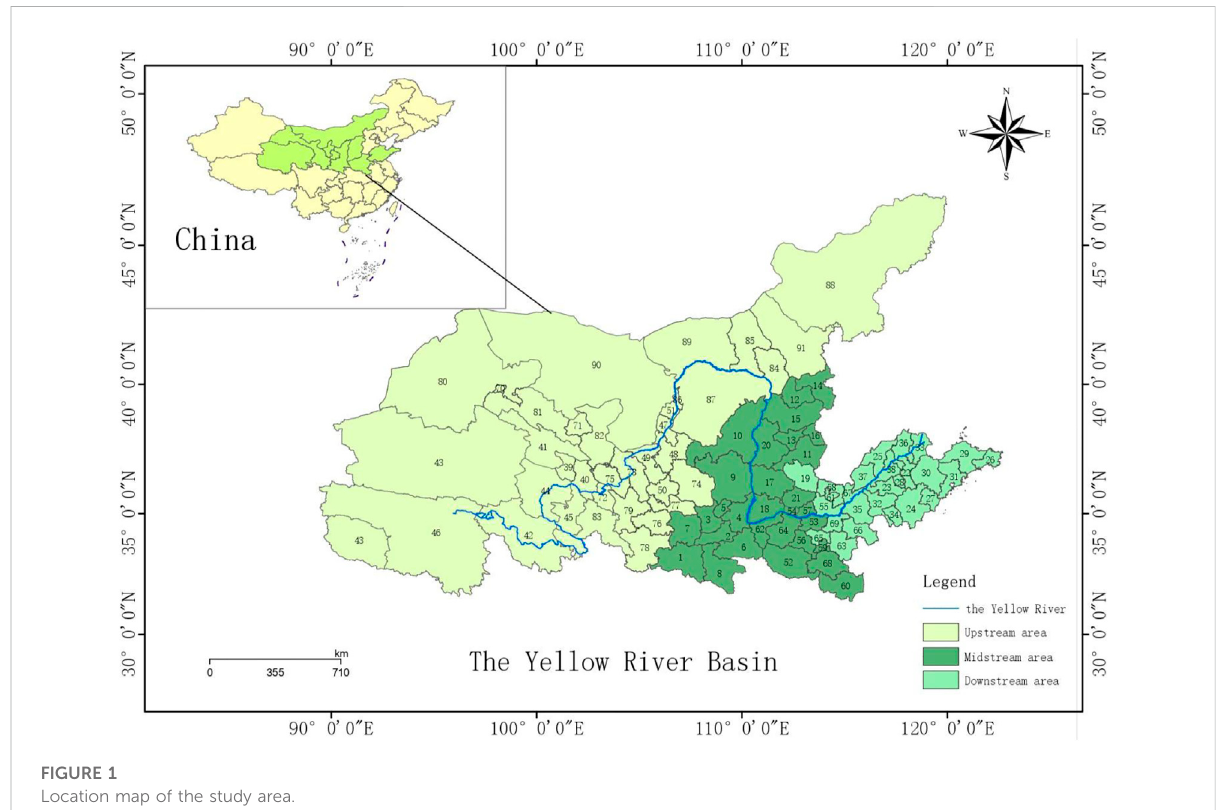
FIGURE 1 Location map of the study